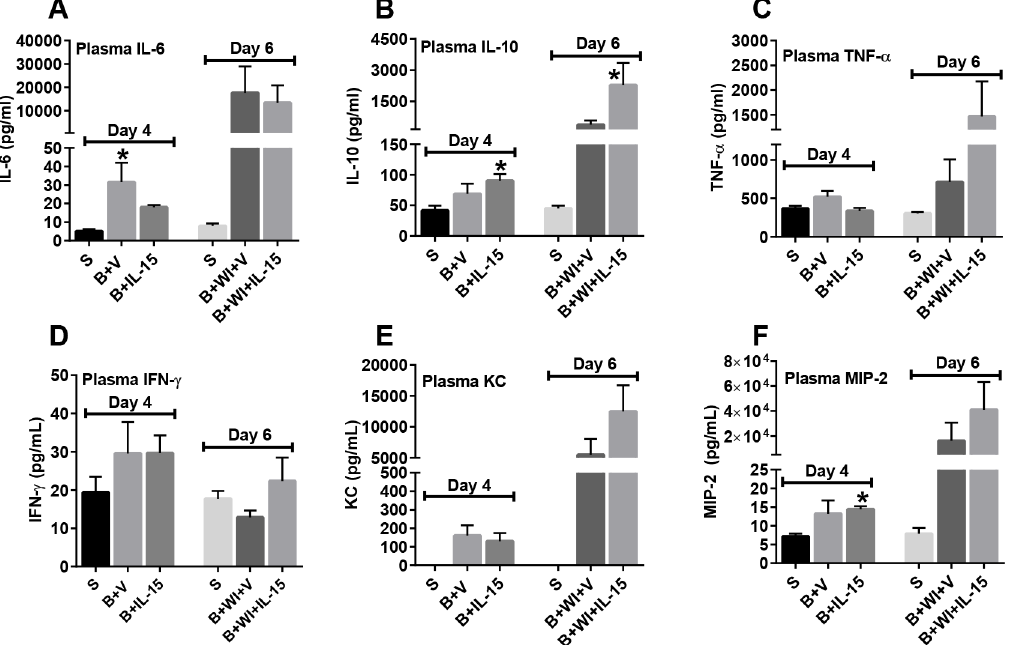
Fig 6. Plasma cytokine levels post burn injury and wound infection. Plasma cytokines including (A) IL-6, (B) IL-10, (C) TNF- α , (D) IFN- γ , (E) KC and (F) MIP-2 were measured using Bio-Rad Bio-Plex assay. n = 6 – 8 in each group and P < 0.05. * significantly different as compared to respective day 4 and day 6 sham